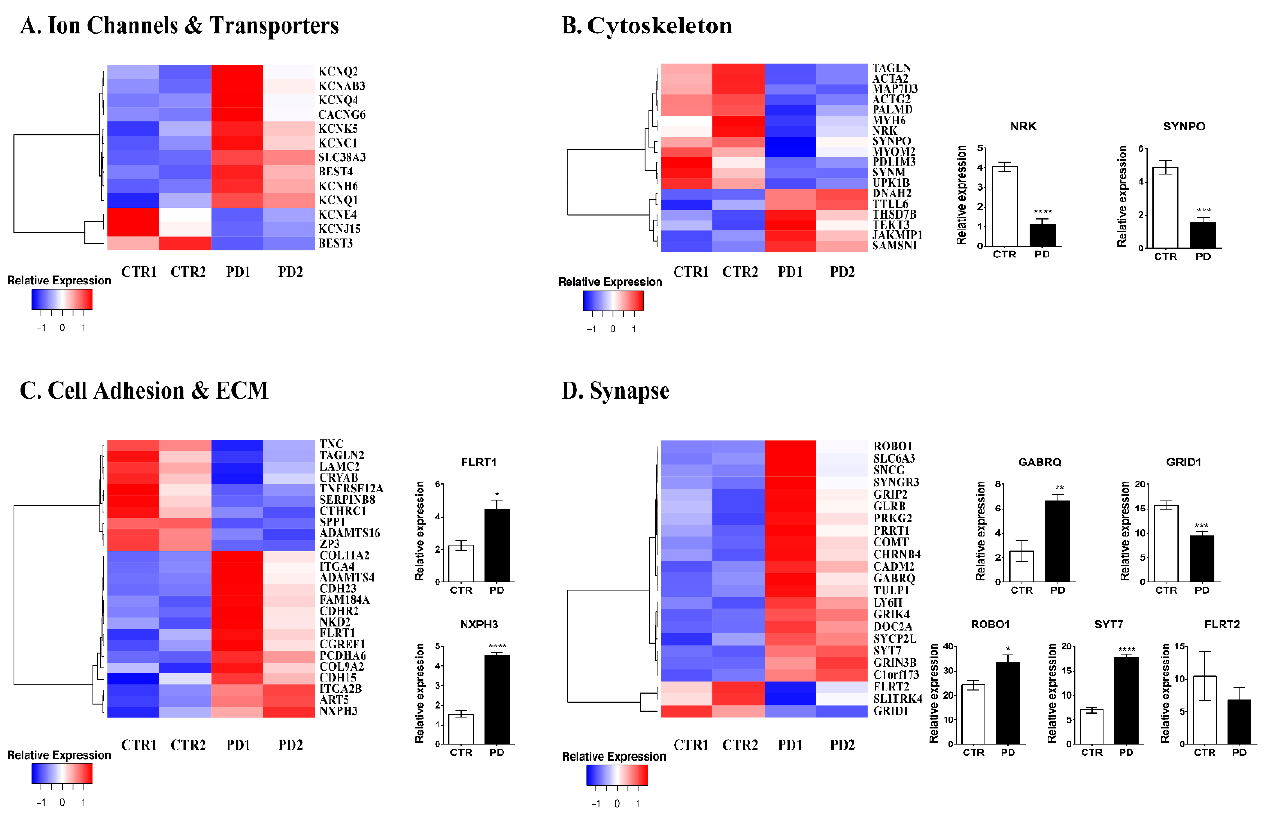
Figure 3. Gene expression analysis of iPSC-derived NPCs. ( A – D ) Differential gene expression between control (two clones from one healthy subject, CTR1 and CTR2) and PD (two clones from one patient, PD1 and PD2) iPSC-derived NPCs at 13 DIV. Heat maps of genes encoding ion channels and transporters ( A ), cytoskeleton ( B ), cell adhesion and ECM ( C ), synapse-associated genes ( D ). RT-qPCR analysis of selected genes 9 ( B – D ) in control and PD NPCs. Gene expression normalized to GAPDH. Data represent mean ± SEM (one-way ANOVA, * p < 0.05, ** p < 0.01, *** p < 0.001, **** p < 0.0001, n = 3).